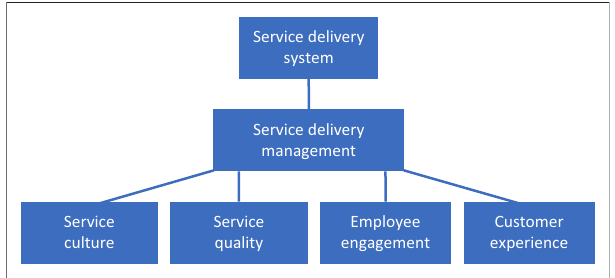
FIGURE 2: Key elements or components of service